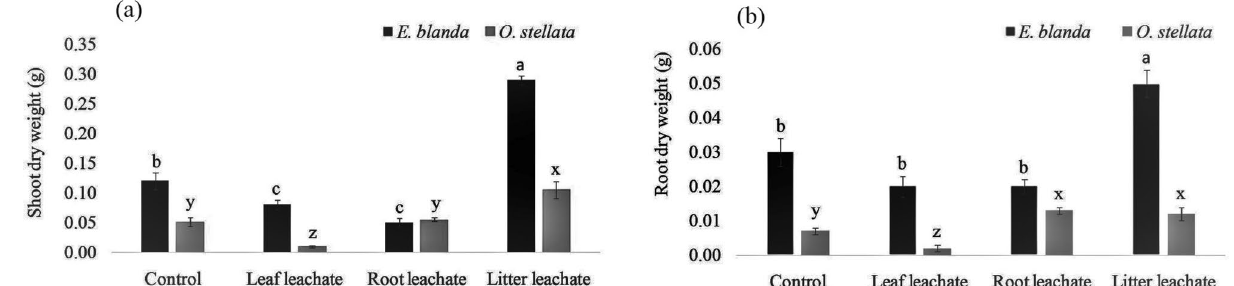
Figure 2. Effect of A. adenophora leachates on ( a ) shoot dry weight and ( b ) root dry weight of native E. blanda and O. stellata. Different letters above the error bar indicate significant differences among the treatments (‘a’, ‘b’, and ‘c’ for E. blanda ; ‘x’, ‘y’, and ‘z’ for O. stellata; p < 0.05).